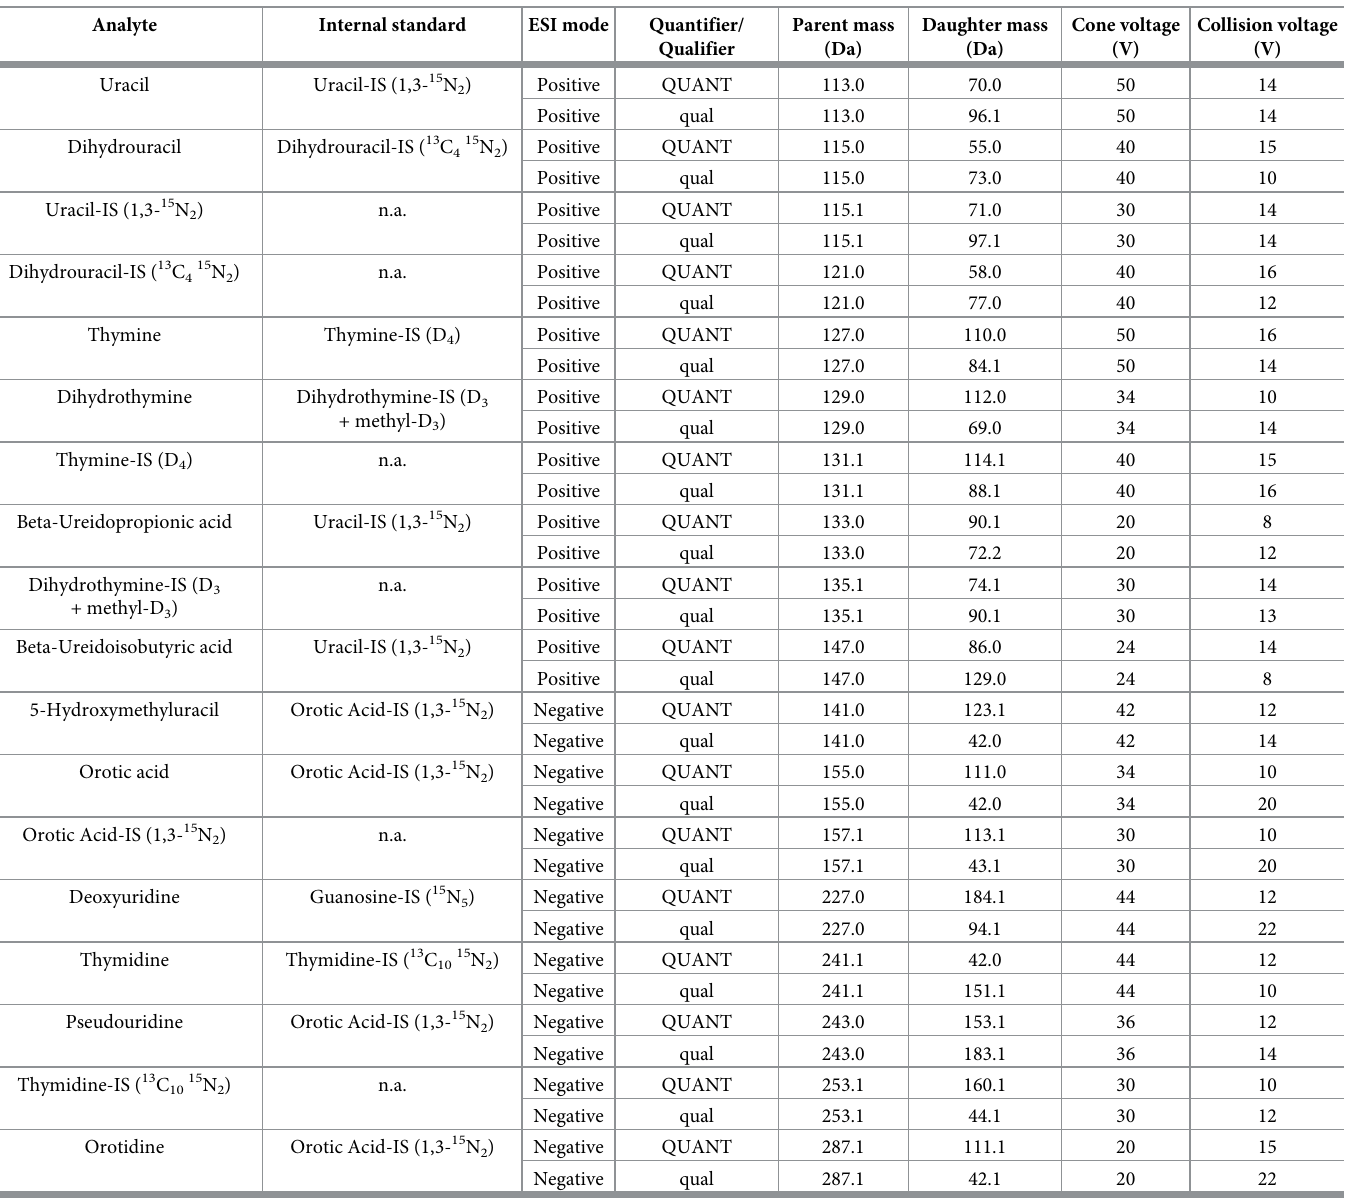
Table 2. Optimized MS/MS settings of pyrimidines and related